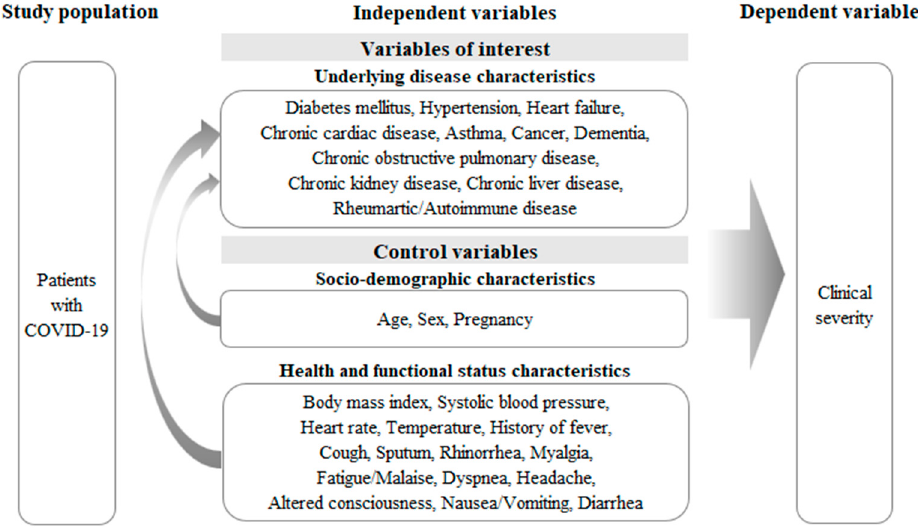
Figure 2. Study framework.